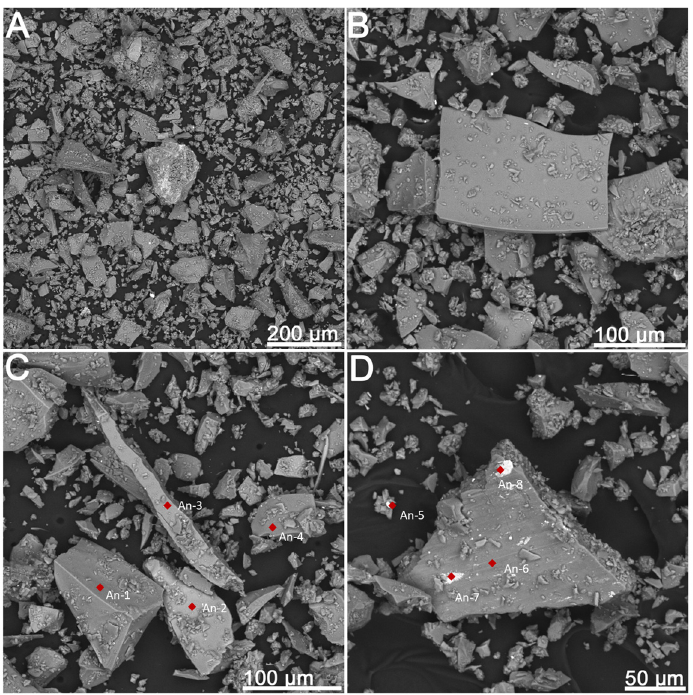
Figure 3. SEM BSE images of the flotation mud waste. ( A ): General view of the untreated dried grains forming the waste. ( B – D ): Enlarged details of single amorphous grains with conchoidal fracture. EDS analysis spots whose values are included in Table 2 are also shown. Table 2. SEM-EDS chemical data (expressed as normalized oxides wt%) for the investigated flotation mud waste (FM). Analysis 1–4, 6 and 8 refer to homogeneous FM grains, whereas Analysis 5 and 7 refer to minor phases with higher BSE yield, which are, respectively, Ni sulphate and Fe oxide; n.d. = not determined.